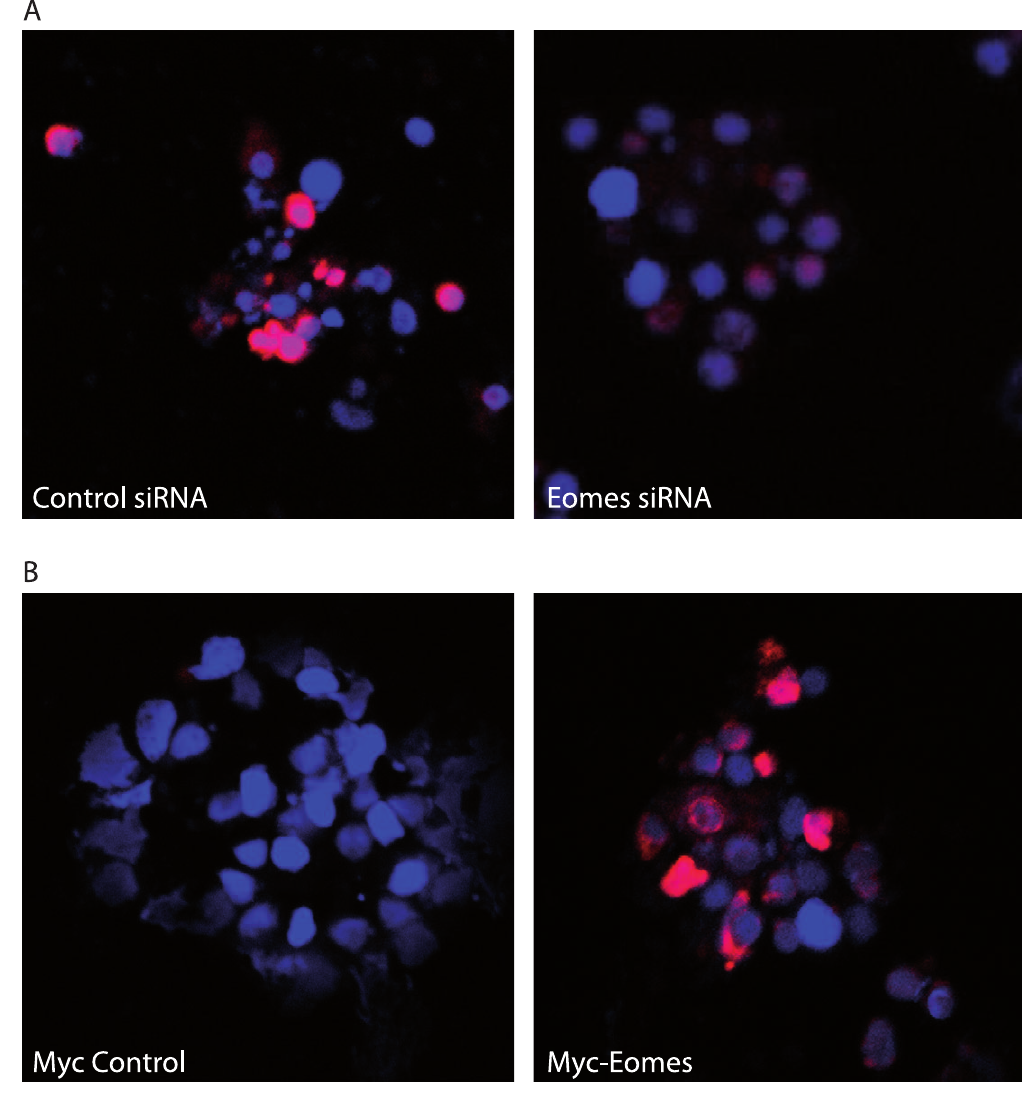
Figure 8. Immunofluorescence study following invitro modulation of Eomes in Atlantic salmon. ( A ) siRNA knockdown of Eomes expression (shown in pink) in spleen lymphocytes after 48 h. ( B ) Myc-labelled Eomes ectopic expression was detected with fluorescence labelling (pink) using alexafluor 594. Nuclear staining was performed with DAPI (blue).